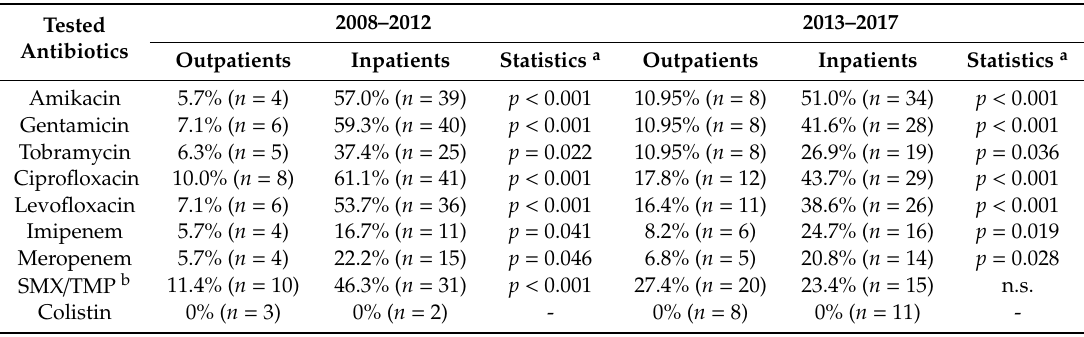
Table 1. Percentage of resistant Acinetobacter strains to relevant antibiotics from the inpatient and outpatient departments (2008–2017).